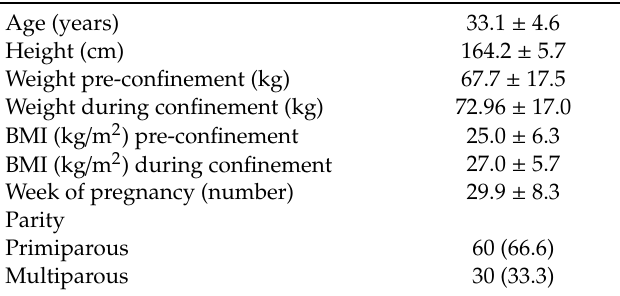
Table 1. Participants’ general